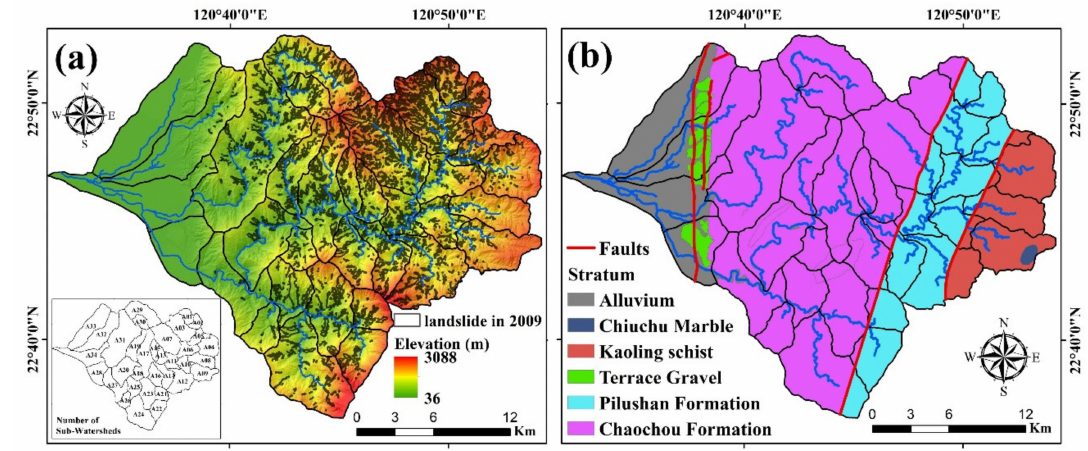
Figure 2. The distribution of elevation, landslide after 2009 Typhoon Morakot, and sub-watersheds ( a ), geological settings ( b ), in the ARW